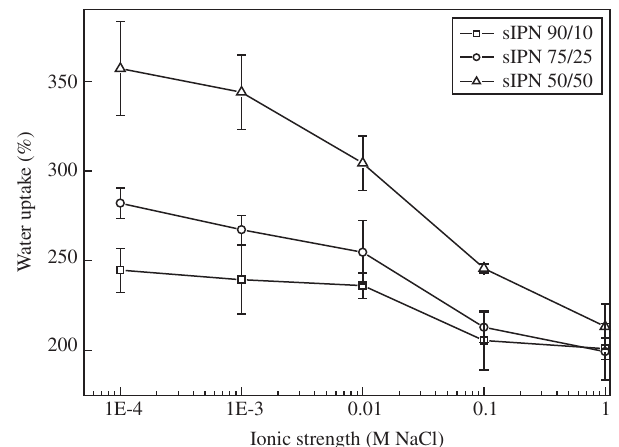
Figure 4. Effect of the ionic strength of the solution on the water uptake (WU) of the s-IPN PVA/PES hydrogels.